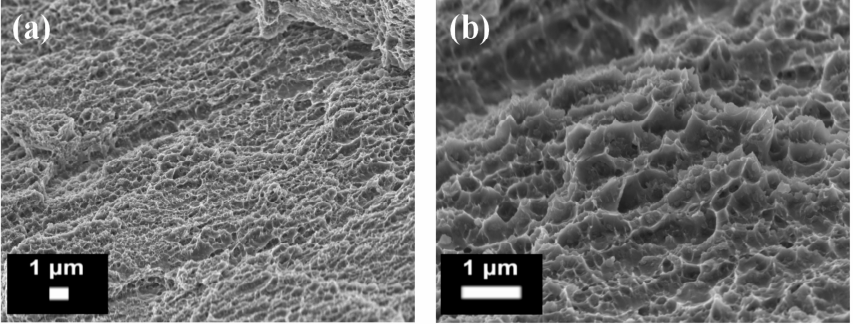
Figure 13. Example of a fracture surface of an AlSi10Mg alloy obtained by means of SLM observed by FESEM, at ( a ) low; and ( b ) high magnifications.